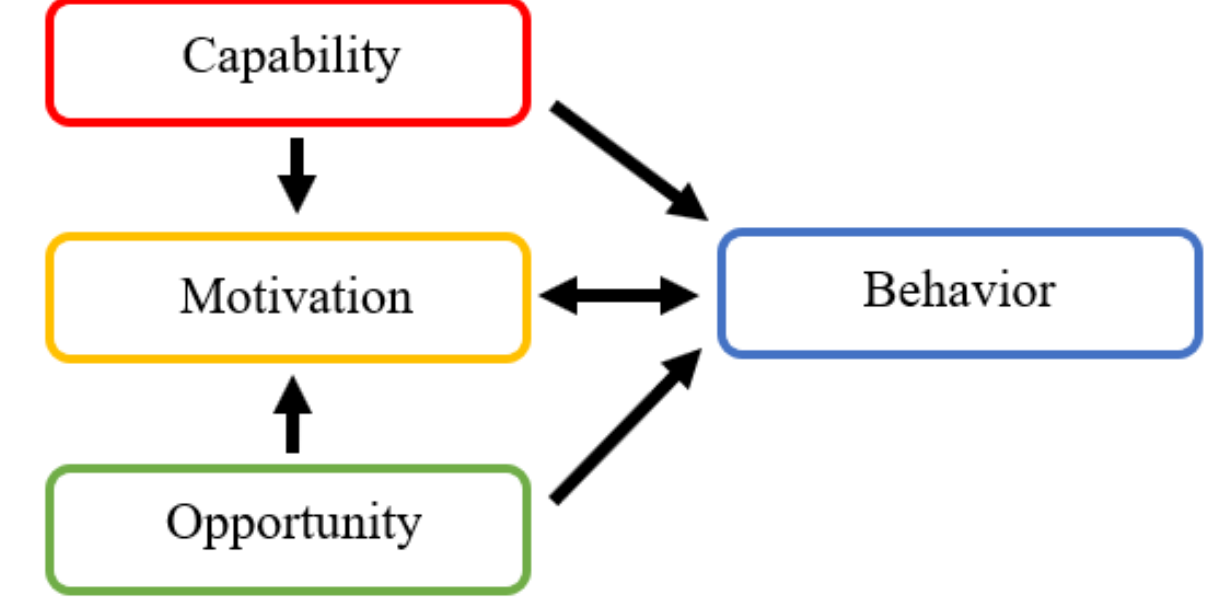
Figure 1. The capability, opportunity, motivation-behavior system. This system is part of the behavioral change wheel and consists of the three behavioral determinants capability, motivation, and opportunity that influence each other and behavior. These determinants can be used to categorize and understand aspects of intersectoral